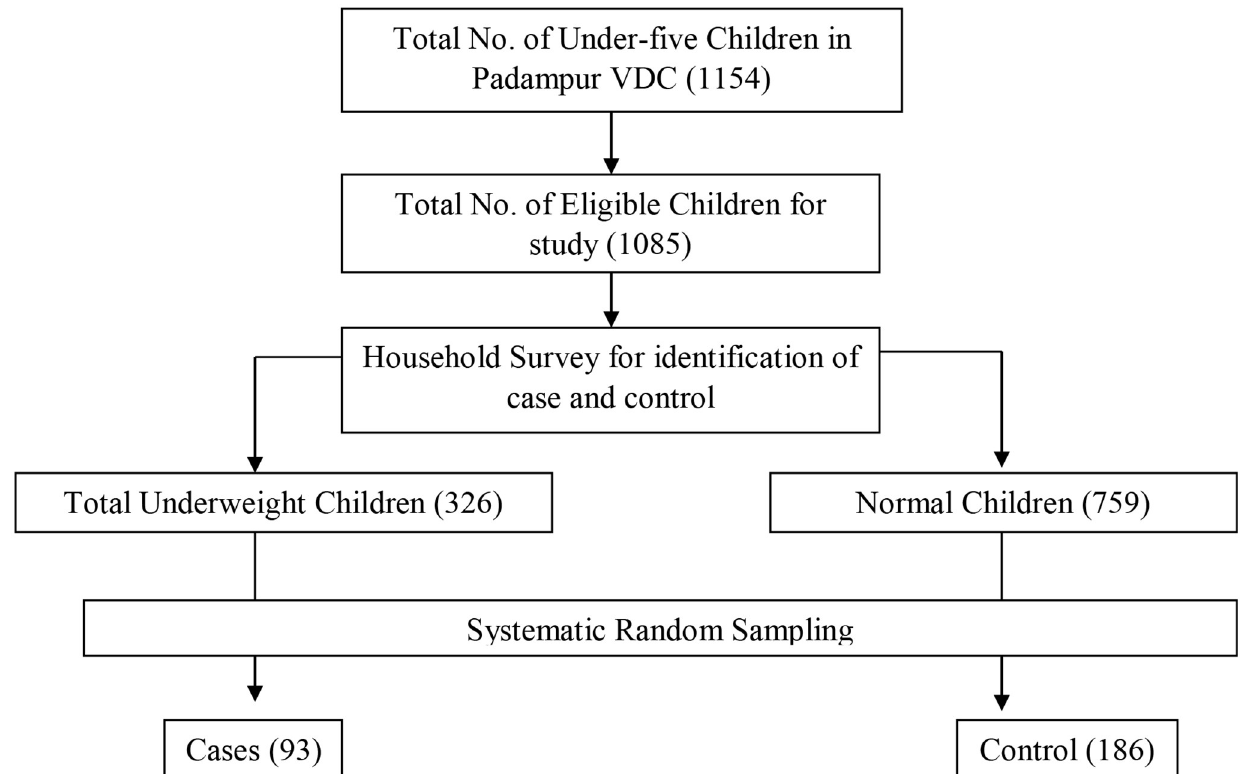
Fig 1. Sampling procedure for selection of cases and